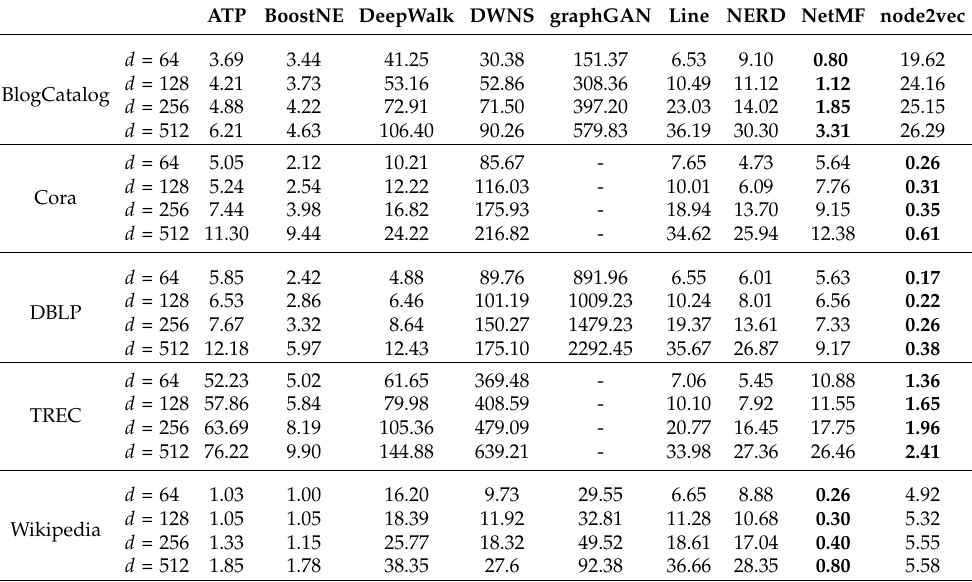
Table 16. Learning time of all embedding methods for different values of d with all datasets.